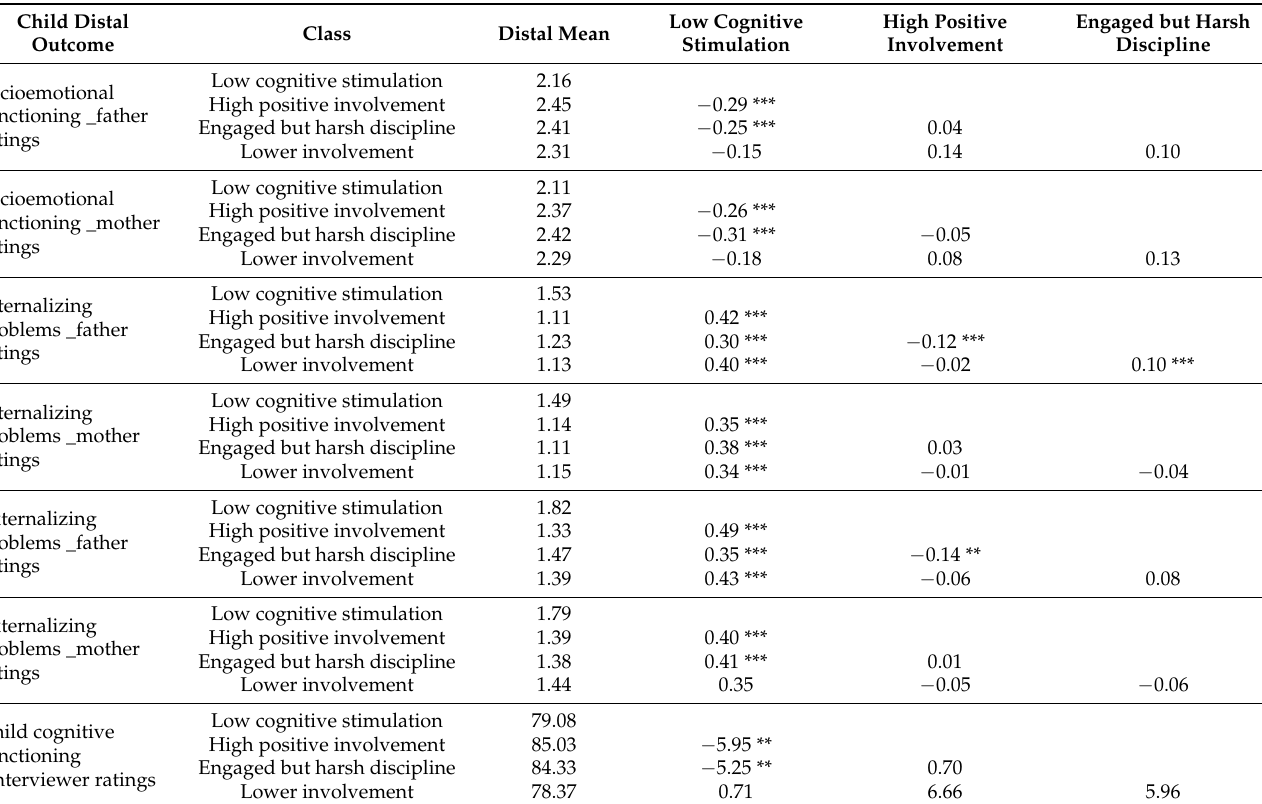
Table 4. Distal mean differences between four latent